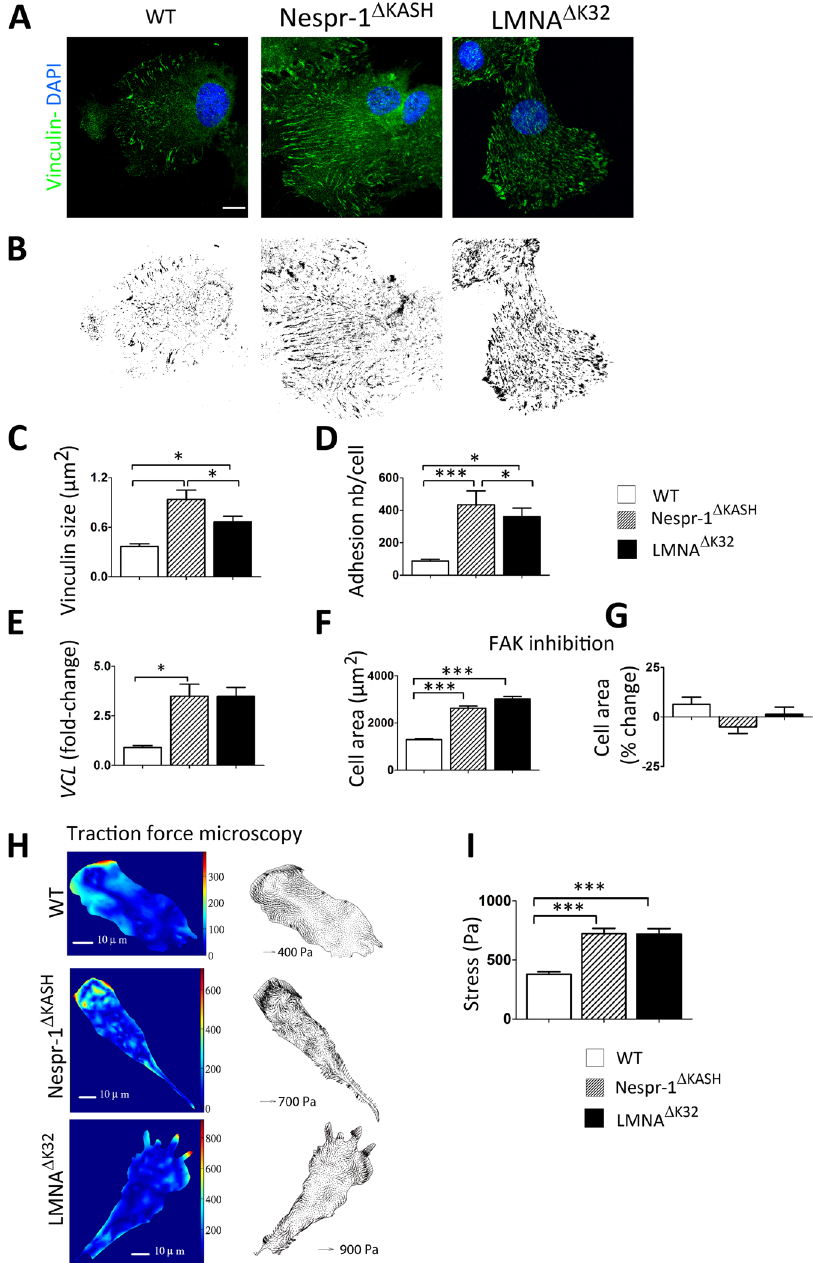
Figure 3. Cell matrix adhesions on soft matrix (12 kPa). ( A ) Confocal images of WT, Nespr-1 Δ KASH and LMNA Δ K32 myoblasts on soft matrix (12 kPa) and stained with antibody against vinculin (green). Nuclei are stained with DAPI (blue). Scale bar: 10 µ m. ( B ) Binary images of vinculin staining obtained from A. ( C , D ) Quantification of vinculin size ( C ) and number of focal adhesions per cell ( D ) in WT, Nespr-1 Δ KASH and LMNA Δ K32 myoblasts obtained from binary images. Values are means ± SEM in at least 12 myoblasts per line; * p < 0.05, ** p < 0.01, *** p < 0.001 compared with WT. ( E ) Histogram of VCL mRNA expression in WT, Nespr-1 Δ KASH and LMNA Δ K32 myoblasts. Values are means ± SEM; * p < 0.05 compared with WT and expressed in arbitrary units (au). Values are means ± SEM, n = 5 in each cell line from 2 separate experiments. ( F , G ) Effects of FAK phosphorylation inhibition on cell spreading in WT, Nespr-1 Δ KASH and LMNA Δ K32 myoblasts. Values are expressed as µ m 2 ( F ) and as percent of baseline values for each cell line ( G ). At least 50 cells of each type were measured, *** p < 0.001 compared with WT. ( H , I ) Traction force microscopy in WT, Nespr-1 Δ KASH and LMNA Δ K32 myoblasts. ( H ) Typical images of traction isostresses (Pa) and traction stress vectors (Pa) in WT, Nespr-1 Δ KASH and LMNA Δ K32 myoblasts. ( I ) Mean values ± SEM obtained from n ≥ 9 in each cell line; *** p < 0.001 compared with